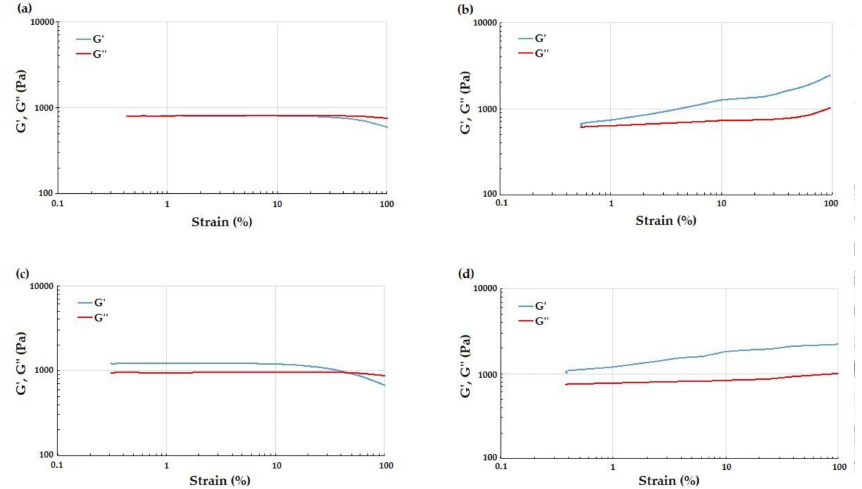
Figure 3. Representative graphs of G’ and G” in the strain sweep tests performed at 20 ◦ C for ( a ) MC-Na005 and ( c ) MC-PBS20; and at 37 ◦ C for ( b ) MC-Na005 and ( d ) MC-PBS20.